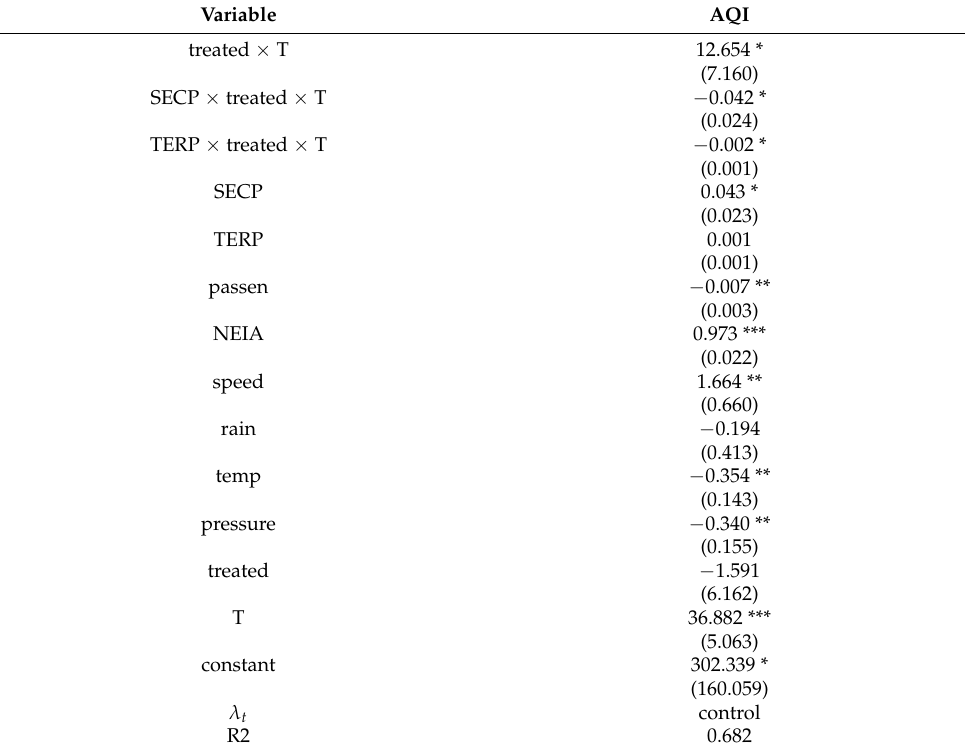
Table 8. Data robust test